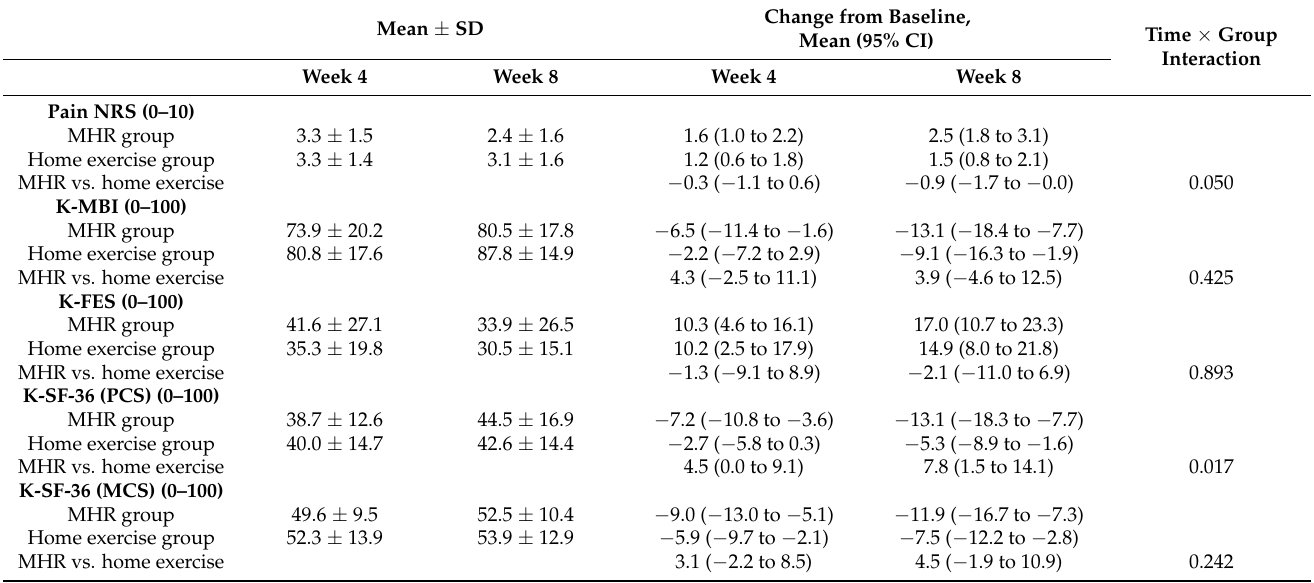
Table 3. Secondary outcomes for adjusted and unadjusted analyses between-group